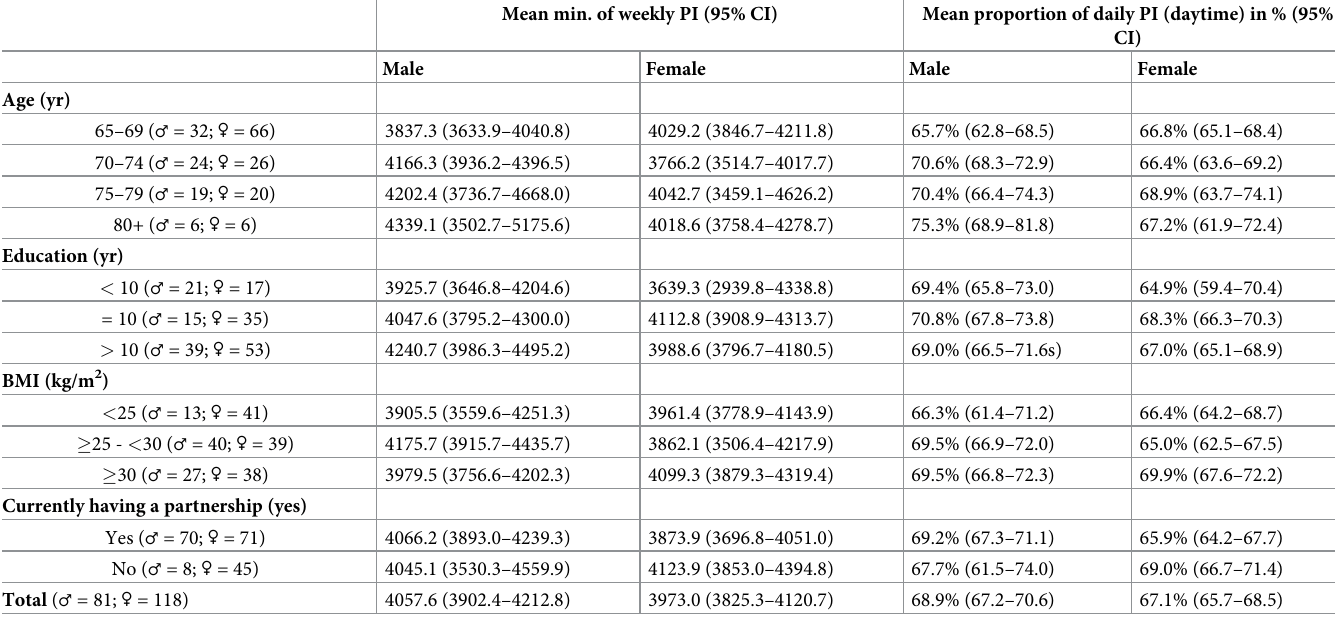
Table 3. Mean duration of weekly PI [min.], proportion of sedentary time of total wake time in minutes. Mean min. of weekly PI (95% CI)